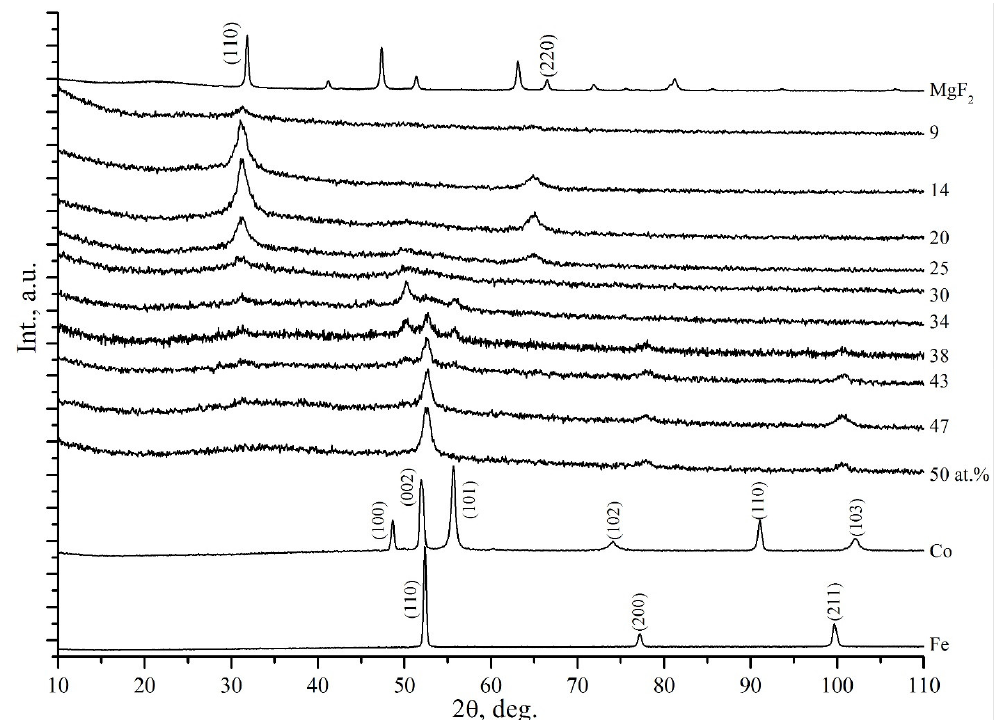
Figure 2. Diffractograms of nanocomposites with different compositions (CoFeZr) x (MgF 2 ) 100 − x on the glass substrates. Nominal content of the metal component x in at.% for the samples is indicated to the right of each diffraction pattern. The upper diffraction patterns in Figure 2 of polycrystal- line cobalt of the hexagonal modification ᾳ-Co and polycrystalline iron of the body-cen- tered cubic (BCC) modification ᾳ-Fe, as well as the lower diffraction pattern of MgF 2 pow- der, are given for comparison. From the analysis of XRD data, it follows that in the range of low concentrations ( x ≤ 25 at.%) the metal alloy CoFeZr is in the X-ray amorphous state in the form of metal clus- ters distributed in MgF 2 nanocrystalline matrix, represented in diffraction patterns for the values x = 9–30 at.% by two wide reflections (110) and (220) at 2θ = 32° and 2θ = 67° from MgF 2 nanocrystals. But just at x = 30 at.% the halo appears in the area of angles 50° < 2θ < 60°, indicating at the beginning of formation of the CoFeZr nanocrystals, and at x = 34 at.%, the first three reflections appear, indicating at the formation of hexagonal nanocrystals based on the α- Co structure, mainly oriented in the plane of the base of hexagonal lattice (002), that is especially clearly visible at x = 38 at.%. However, with a further increase in the metal alloy content, starting from x = 43 at.%, the crystal structure of CoFeZr nanocrystals is rearranged into a cubic volume-centered phase based on α-Fe with a predominant orientation of (110), like that of α-Fe. And al- ready at x = 47–50 at.% in the amorphous MgF 2 matrix (its reflections (110) and (220) dis- appeared at x = 38 at.%), only one nanocrystalline BCC phase of the CoFeZr alloy is pre- sent in the composites. Figure 3 shows diffraction patterns of the samples with different compositions ob- tained on glass-ceramics substrates. The two lower diffraction patterns were obtained from MgF 2 powder and a glass-ceramics substrate. This figure also shows the initial alloy Co 45 Fe 45 Zr 10 on the glass-ceramics substrate without MgF 2 , which provides an intense